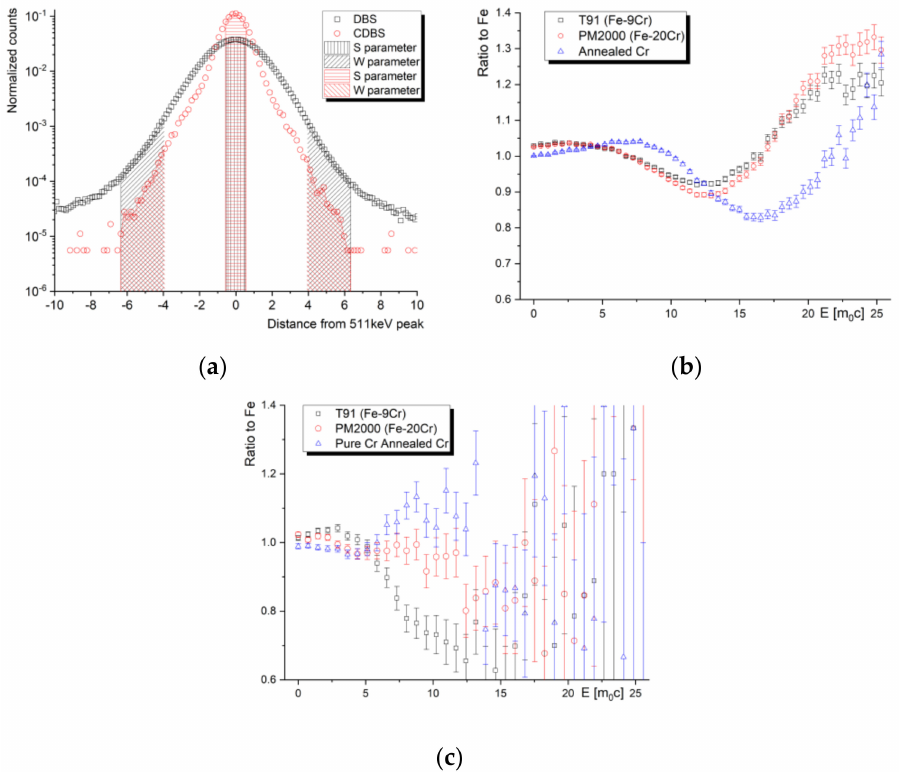
Figure 6. Normalized DBS spectra ( a ) of pure Fe obtained from CDBS matrix as the main diagonal (referred to as DBS) and as the sum of the lines (columns), respectively (referred to as CDBS). DBS ratio curves, relative to Fe, of two steels with different Cr content and pure Cr sample obtained for the first case ( b ) and for the second case ( c